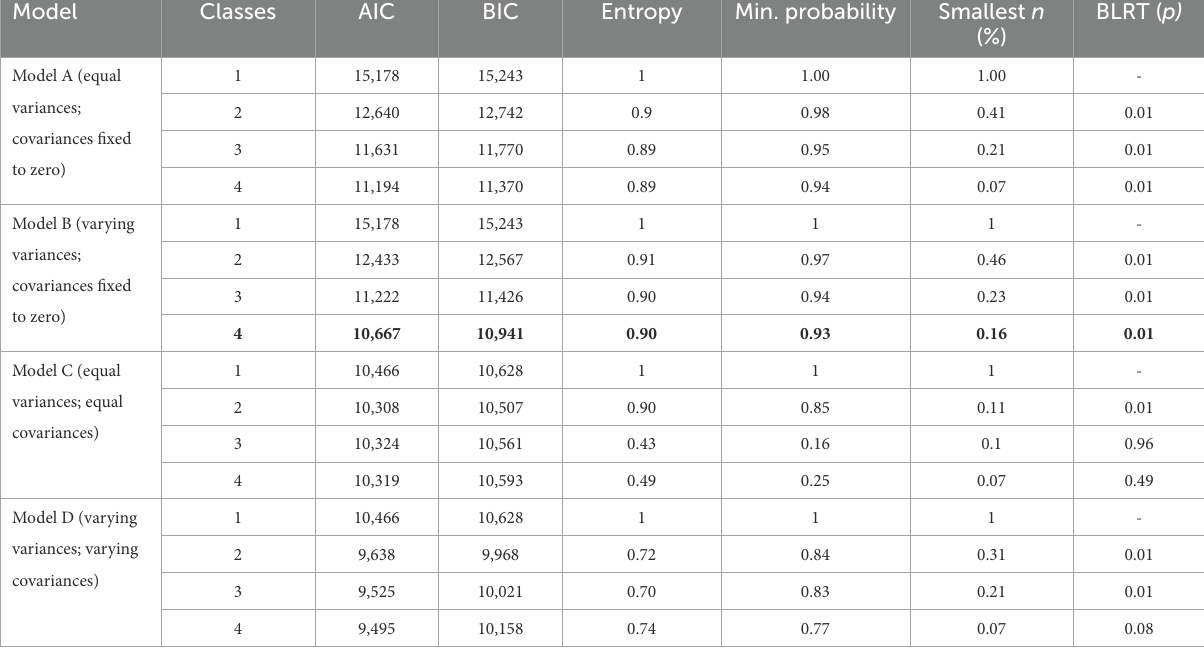
TABLE 3 Fit indices and LPA results with Models A, B, C, and D and their profile solutions indicating AIC, BIC, Entropy, and bootstrapped likelihood ratio test.